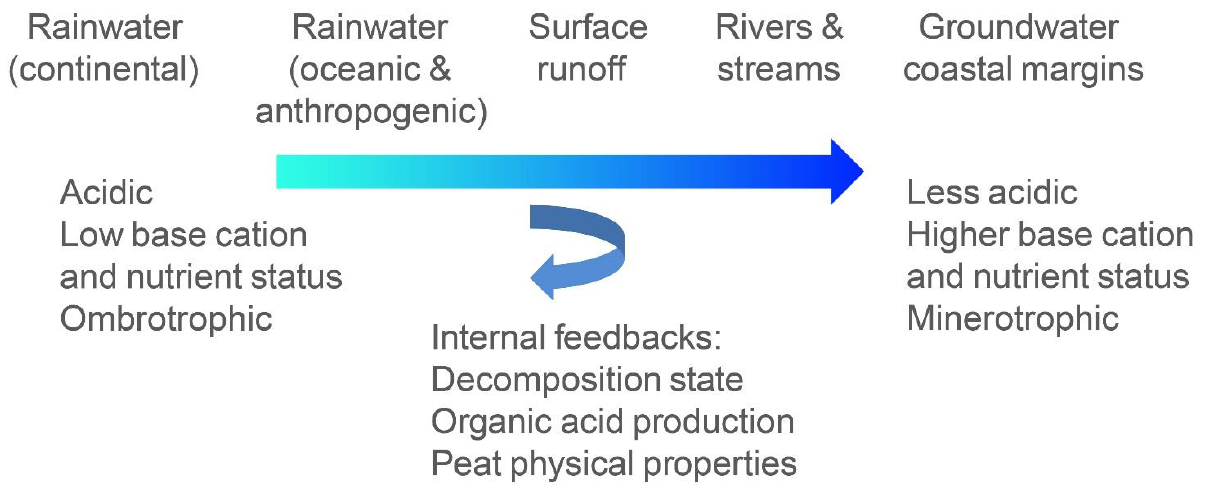
Figure 3. Schematic representation of the hydrochemical influence on peat properties and internal feedbacks, demonstrating increasing solute inputs from left to right. Note that marked gradients in solute concentrations may also occur within the peat profile when groundwater or geological influences transition to rainwater influence (e.g. Muller et al . 2008, Steinmann & Shotyk 1997a, b). decomposability (Grover & Baldock 2013). The to differentiate peat soils (Rydin & Jeglum